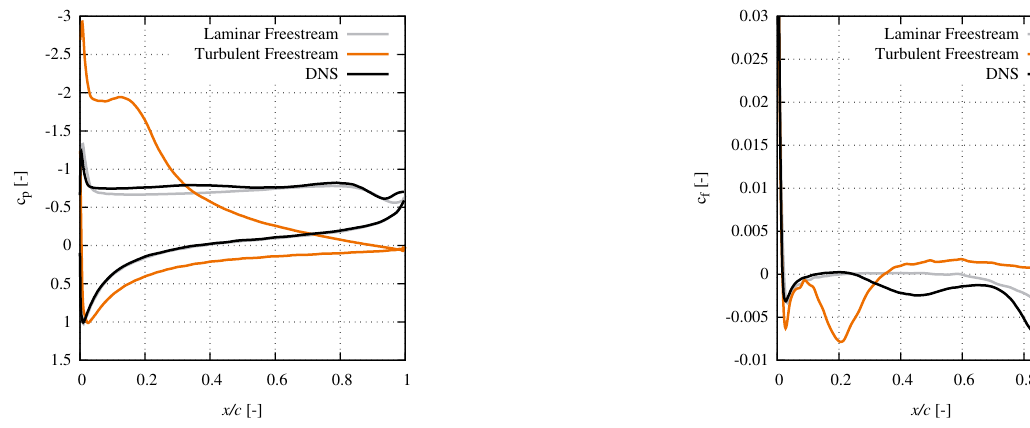
Figure 13. Averaged pressure friction coefficients along the wing surface. DNS data [24] with laminar freestream for comparison and